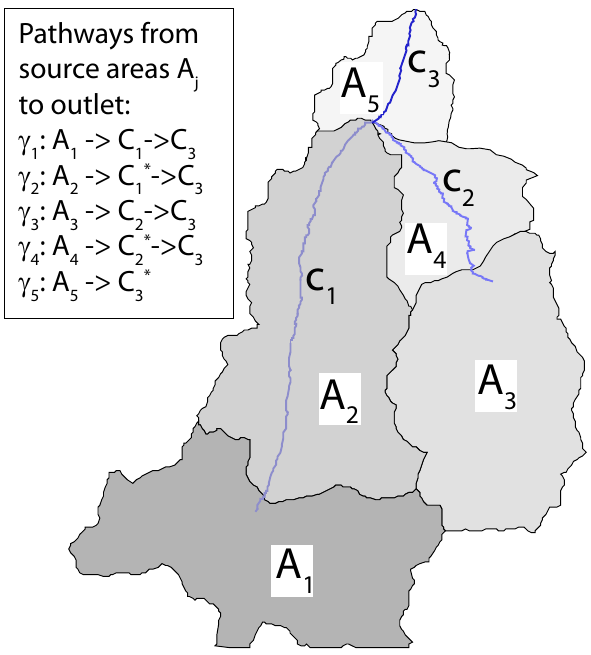
means that the j